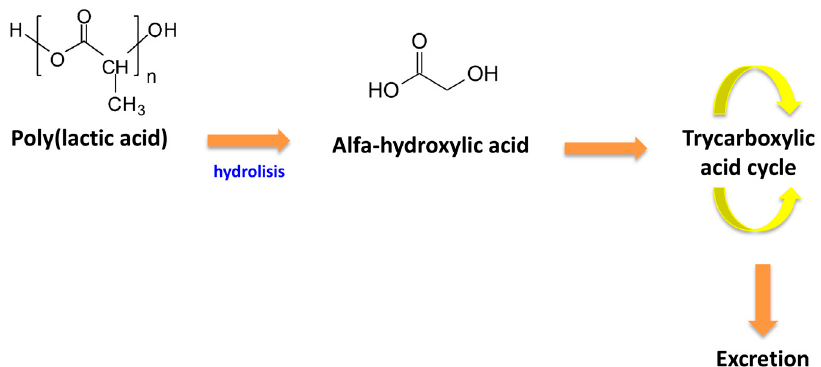
Figure 6. Polylactic acid ( PLA) degradation in the human body.